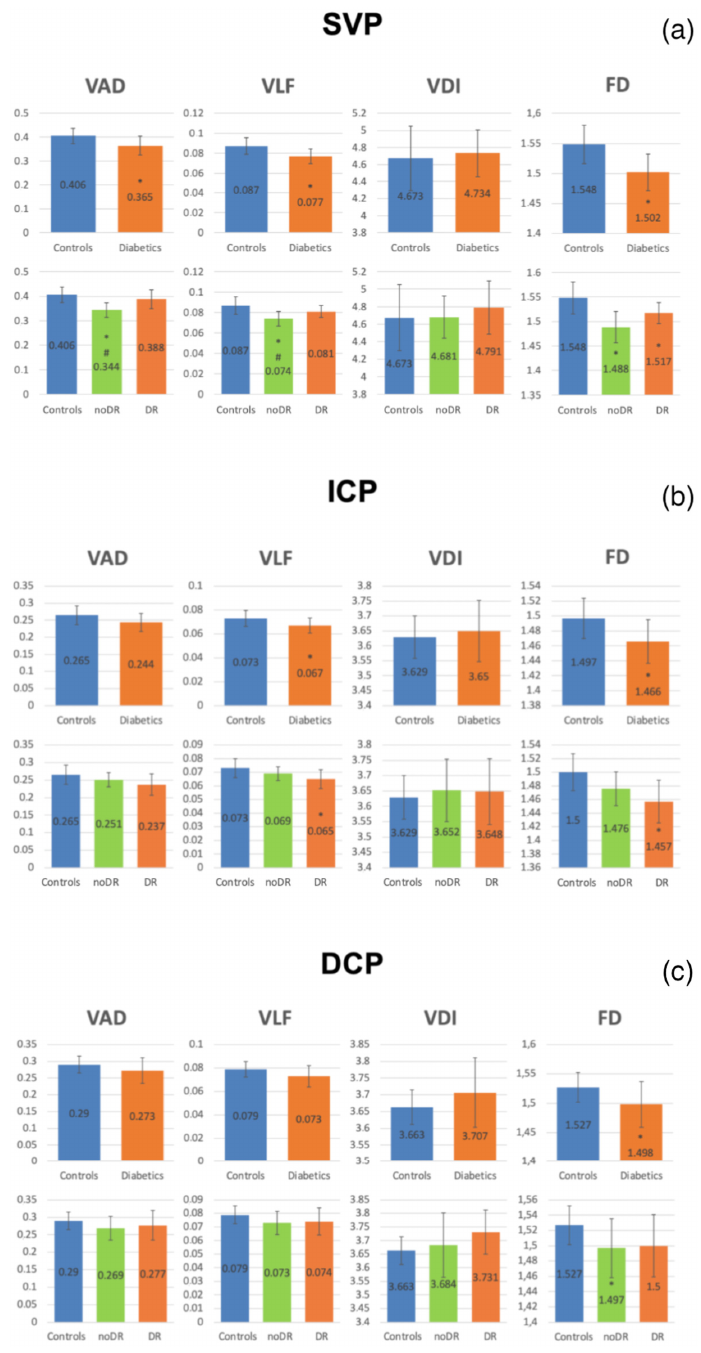
Figure 4. Representation of vessel area density (VAD), vessel length fraction (VLF), vessel diameter index (VDI), and fractal dimension (FD) of the superficial vascular plexus (SVP, a ), intermediate (ICP, b ) and deep capillary plexus (DCP, c ) in all diabetic eyes versus controls (upper row) and in diabetic eyes without diabetic retinopathy DR (noDR) and with DR (DR), separately compared to control group (lower row). ( a ) significant reduction of VAD, VLF and FD was found in diabetic eyes versus controls. The VAD and VLF of noDR group showed a significant reduction compared to controls and to DR. FD showed a significant reduction in both noDR and DR groups versus controls. ( b ) significant reduction of VLF and FD was found in diabetic eyes versus controls and confirmed in DR group, when separately evaluated. ( c ) significant reduction of FD was found in diabetic eyes versus controls and still present in noDR group, when separately evaluated. * Statistically significant di ff erence compared to controls; # statistically significant di ff erence compared to DR